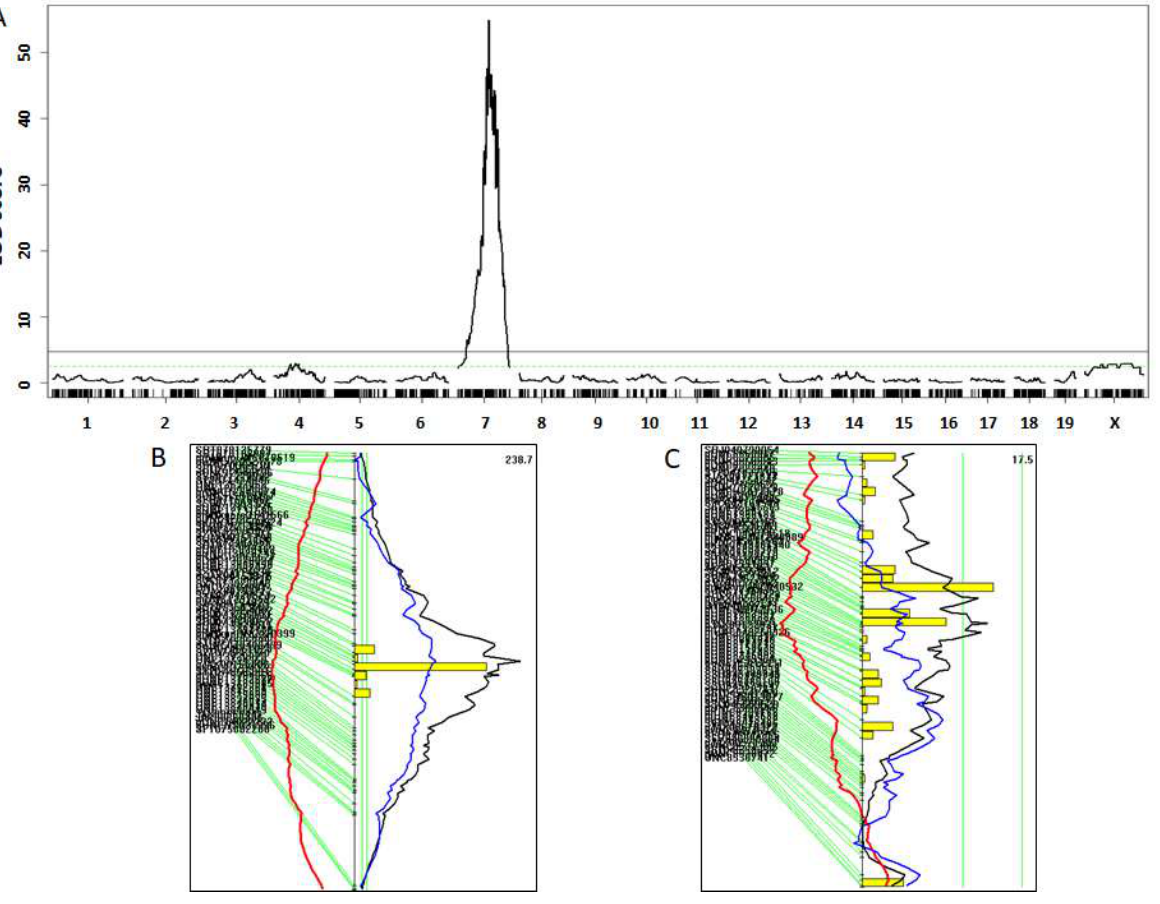
Figure 2. Testing the reliability of the F2 cohort derived from BALB- Apoe −/− and LP- Apoe −/− mice via mapping the albino coat color locus. ( A ) Genome-wide scan to detect a huge albino locus to chromosome 5 at 88.1 Mb. The X axis shows the chromosomal position and the Y axis shows the LOD score. Two horizontal lines represent the genome-wide thresholds for significant linkage at p = 0.05 (black) and suggestive linkage at p = 0.63 (green). ( B ) Interval mapping plot for chromosome 7 harboring the huge albino locus. The curved black line denotes LOD score calculated at a 1-Mb interval along the chromosome. The blue and red lines denote dominant and additive regression coefficients, respectively. Yellow histograms denote the confidence interval estimated by the bootstrap test. Two vertical green lines denote genome-wide significance thresholds at p = 0.63 and p = 0.05, respectively. Genetic markers used are shown on the left of the figure. ( C ) Interval mapping plot for chromosome 4 harboring a suggestive locus for coat color.